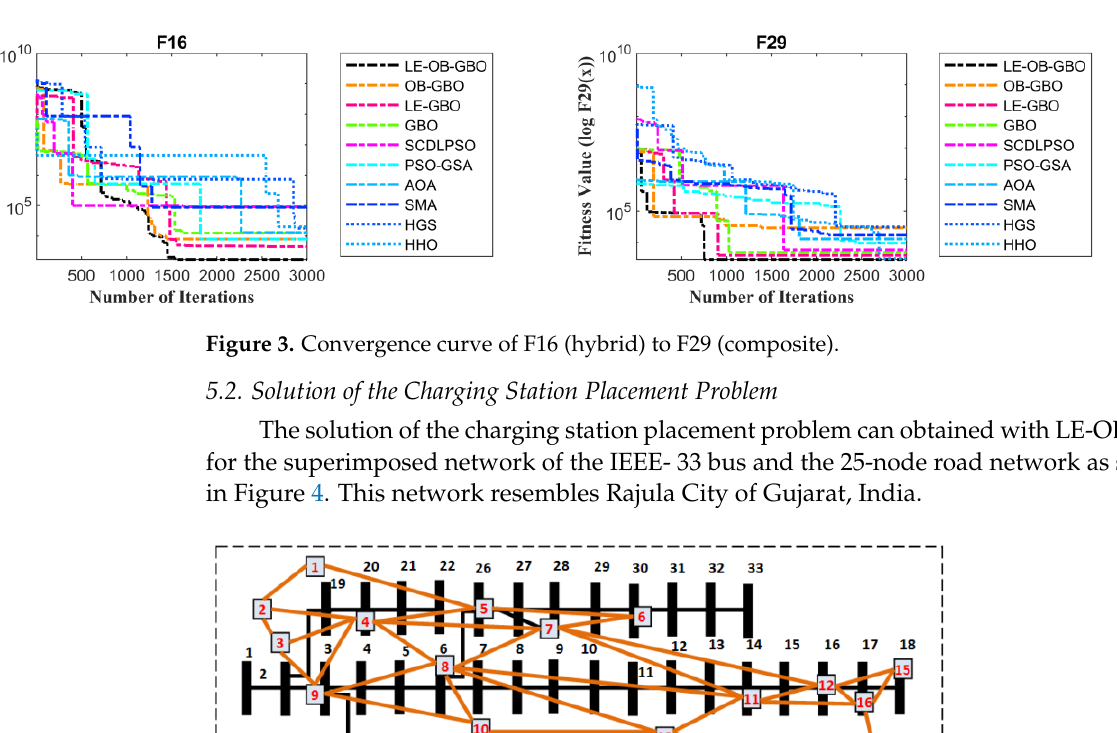
Figure 2. Convergence curve of F1 (unimodal) and F5 (multimodal).